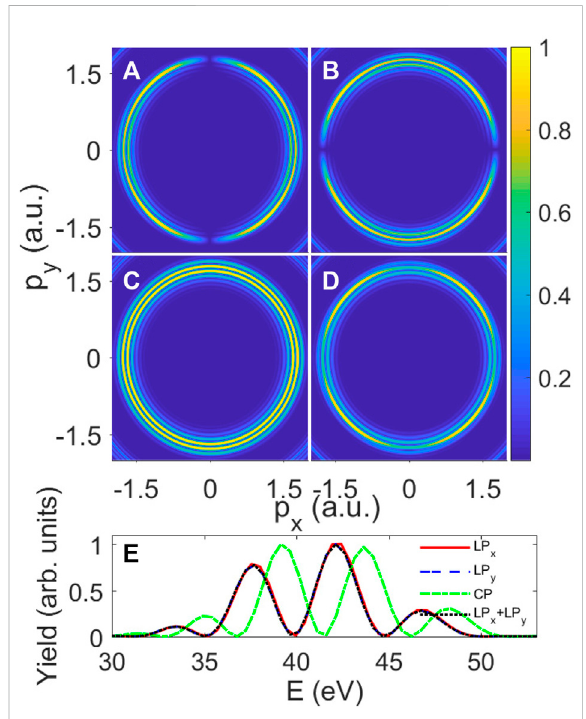
FIGURE 7 Normalized photoelectron momentum distribution of hydrogen atoms in the presence of a circularly polarized laser pulse with different polarization. (A) Linearly alone x , (B) Linearly alone y , (C) Circularlyand (D) superpositionof (A,B) .Curvesin thepanel (E) are thephotoelectronspectraof (A) the redsolidline, (B) the blue dashed line, (C) the green dashed – dotted line, and (D) the black dotted line. Laser intensity is I 0 =5×10 18 W/cm 2 . The rest of laser parameters are the same as those in Figure 3A.